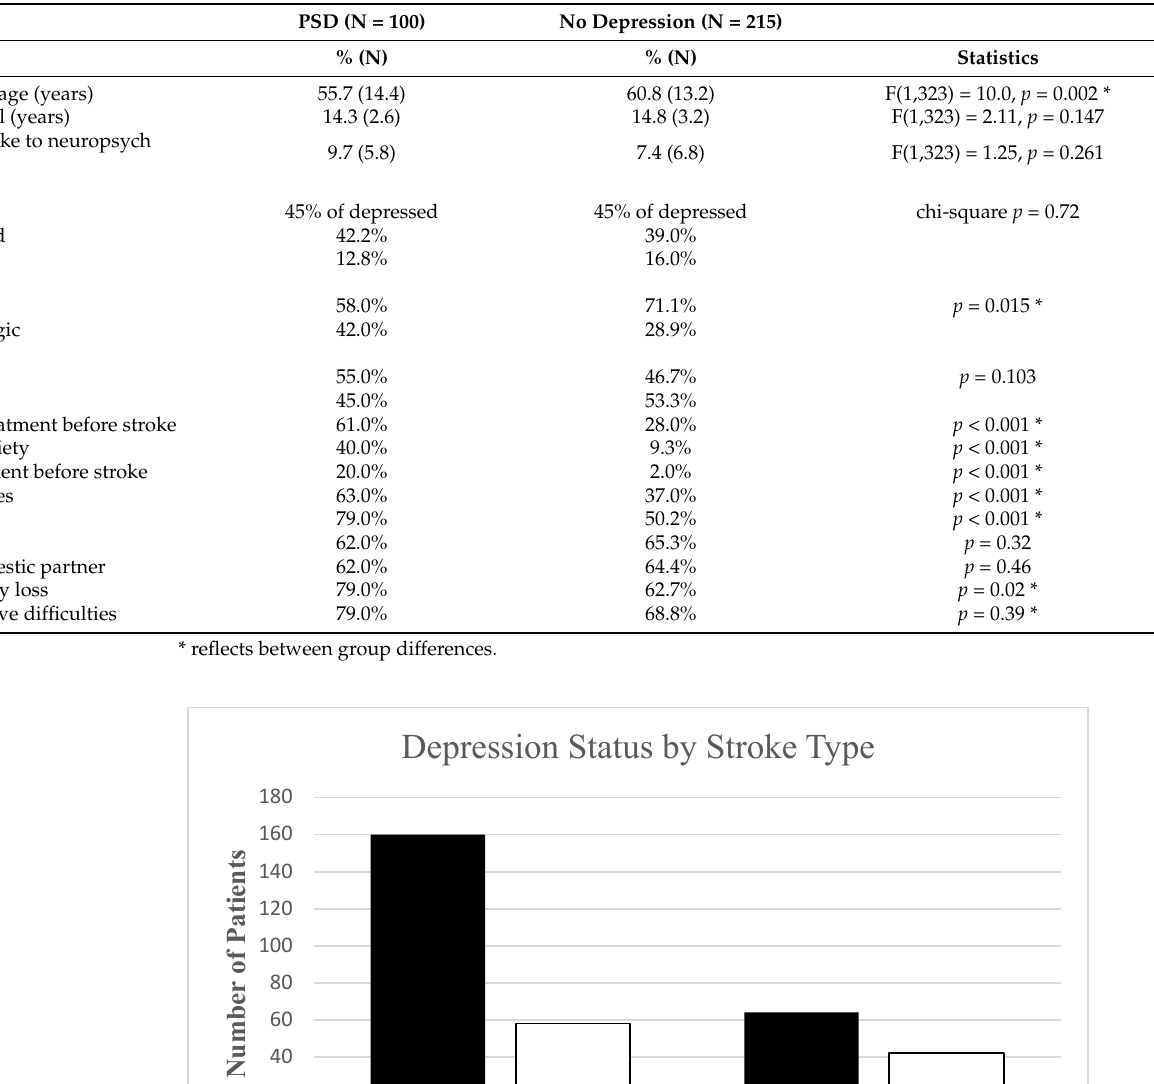
Table 3. Display of demographic, stroke-related, psychosocial, and cognitive characteristics divided by depression status (poststroke depression, no depression).